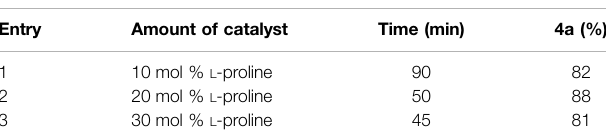
TABLE 2 | Effect of catalyst